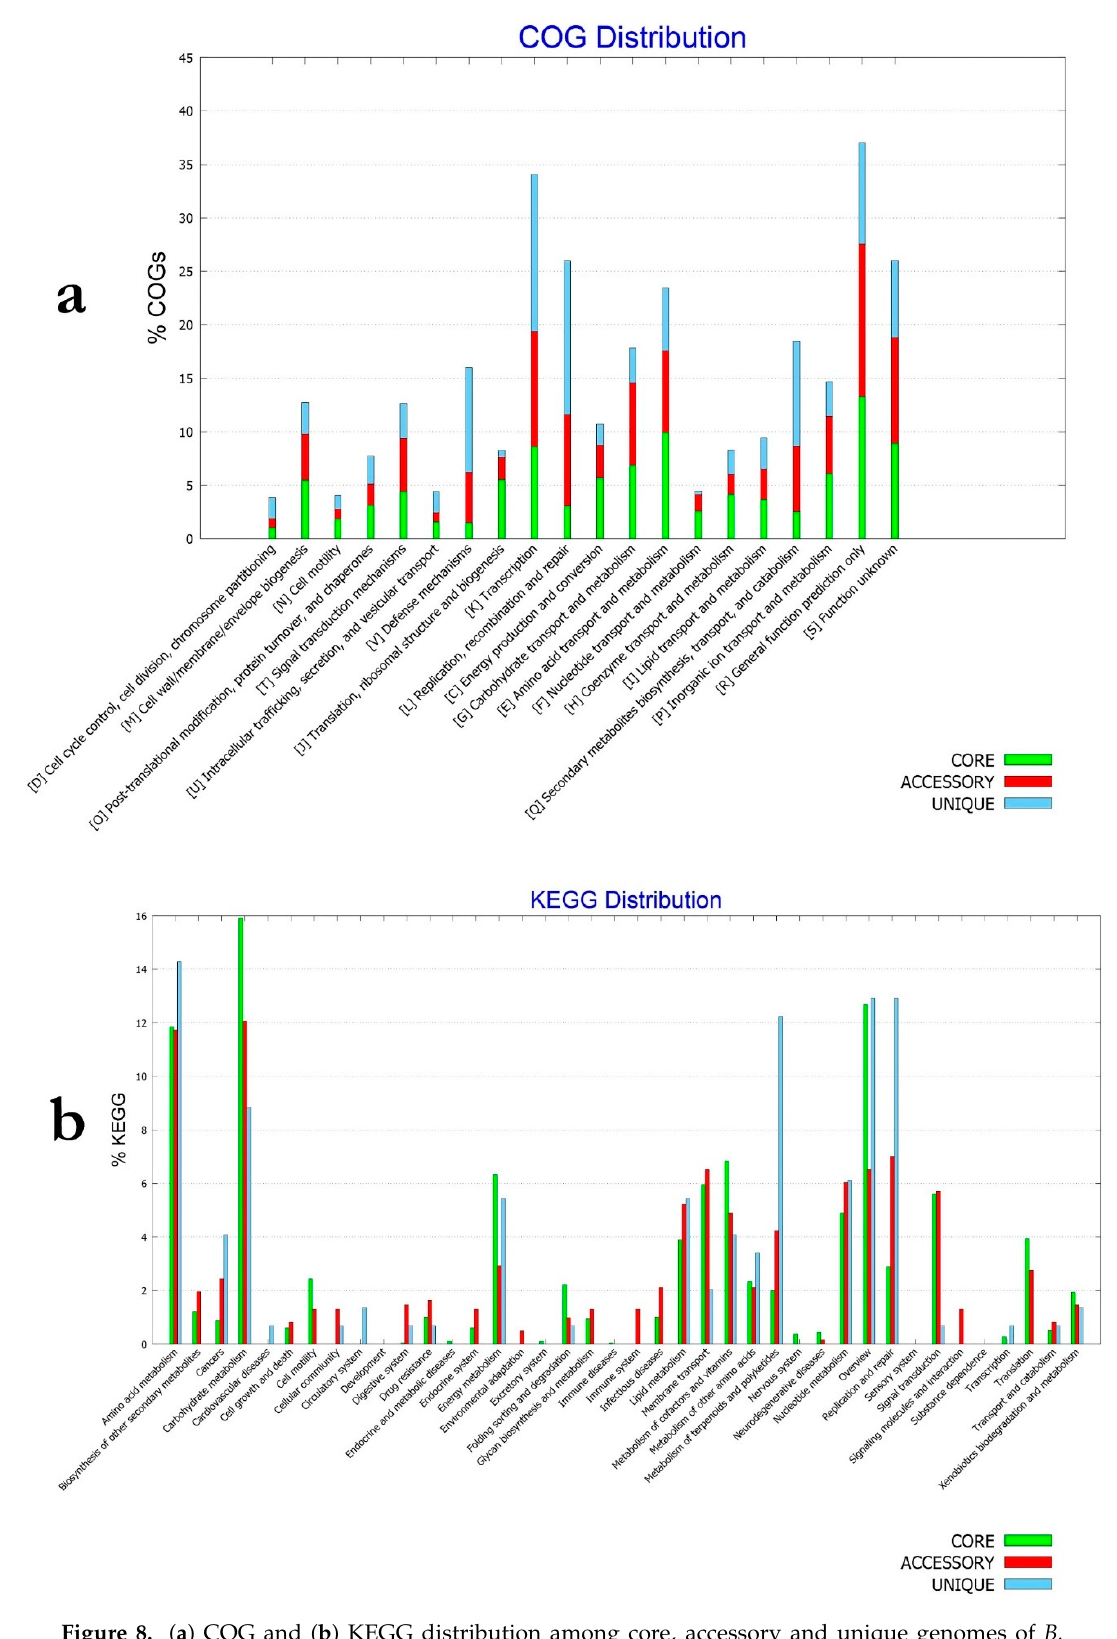
Figure 8. ( a ) COG and ( b ) KEGG distribution among core, accessory and unique genomes of B. 530 velezensis isolates. 531 Disease indexes of plants treated by OEE1 were about 0.3 and 1 for the protective and curative 532 treatments, respectively. Chemical fungicide was less effective in reducing disease severity, 533